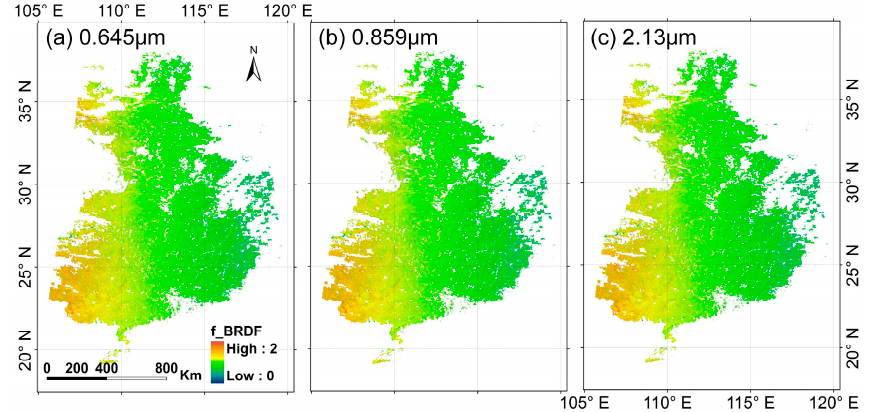
Figure 11. Comparisons of TERRA and AQUA MODIS band ratios in the ( a ) 0.645 μ m, ( b ) 0.859 μ m, and ( c ) 2.13 μ m bands.